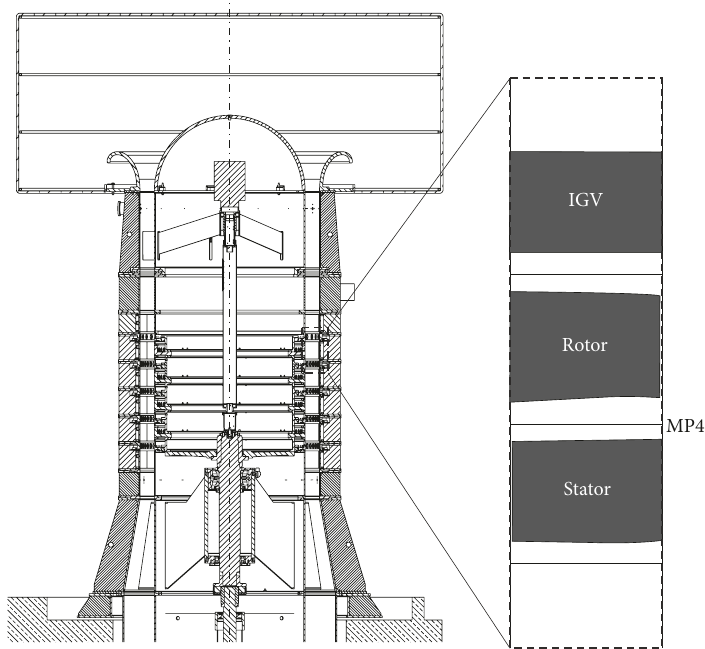
Figure 1: LSRC Dresden, cross section of single-stage